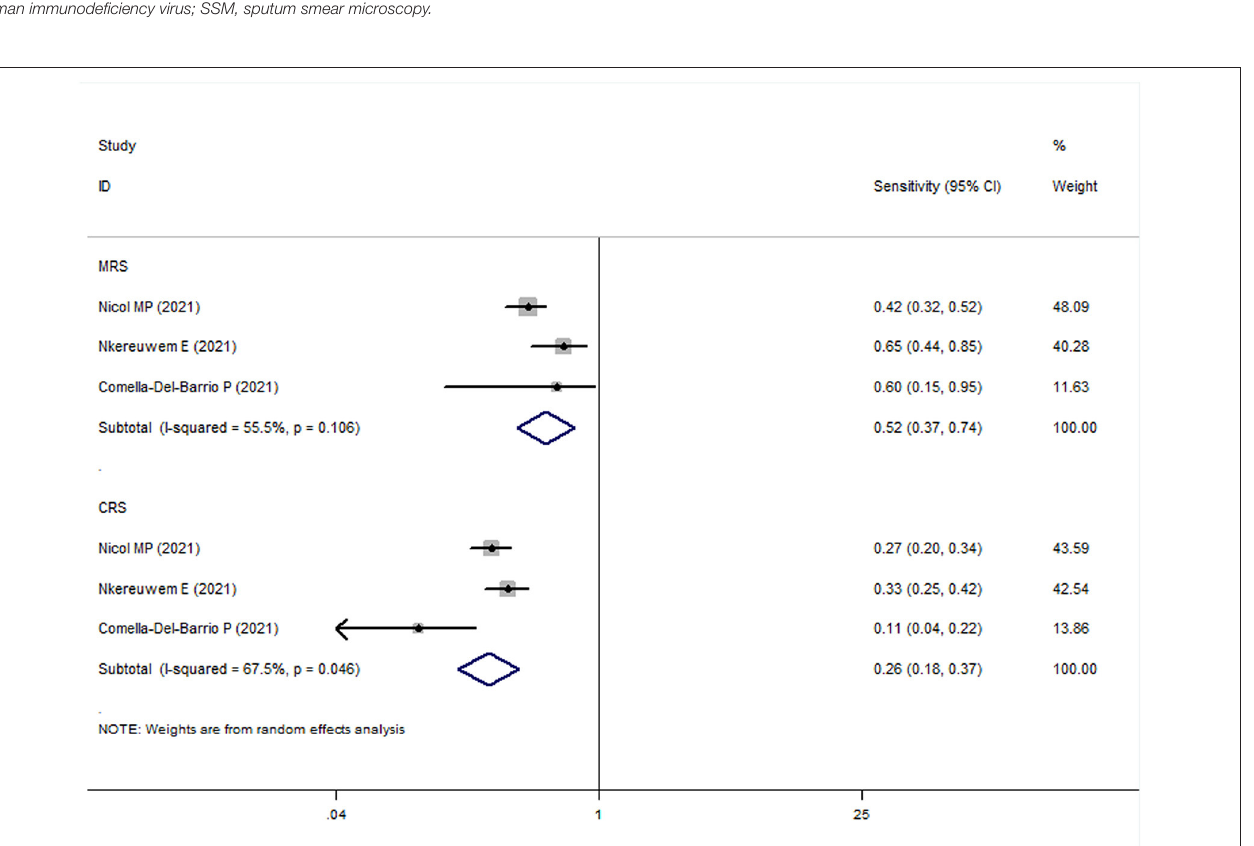
Frontiers in Public Health |